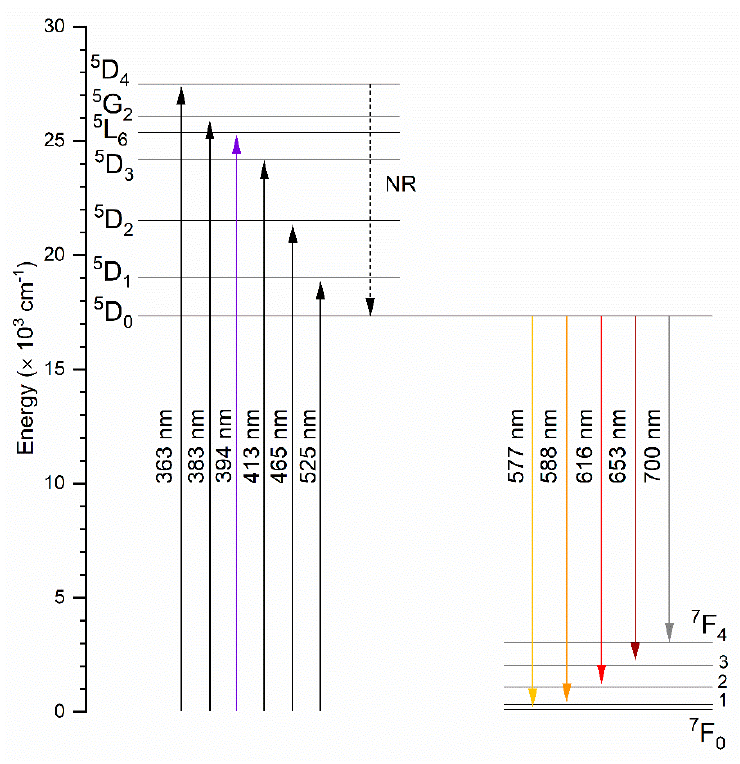
Figure 6. The simplified energy level scheme for Eu 3+ ion in silicate-substituted strontium-doped hydroxyapatite.